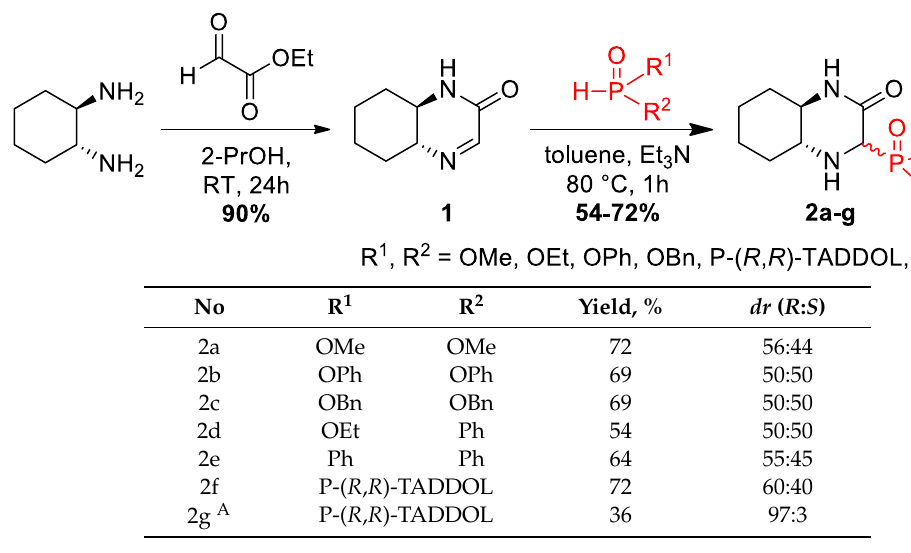
Table 2. Synthesis of aminophosphonates and phosphine oxides.